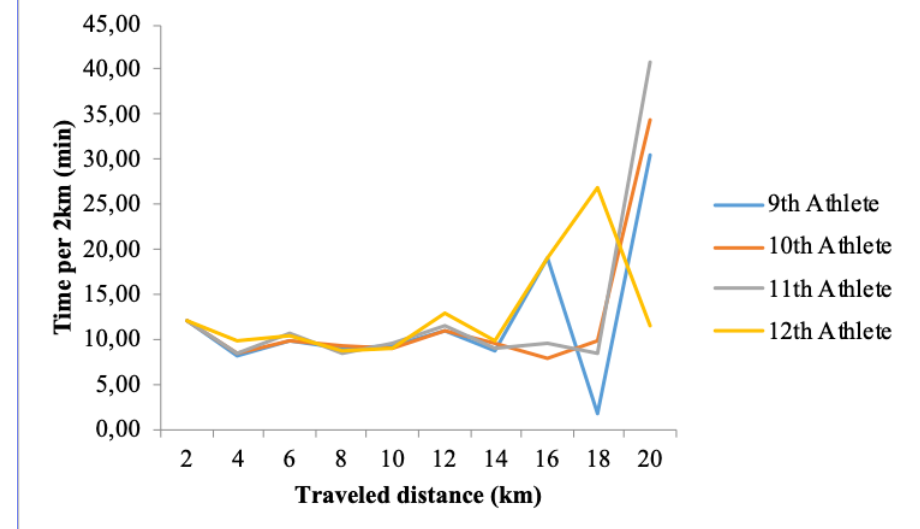
Figure 5. The individual times per 2km of the group> 30% of the athletes in the 20km of race